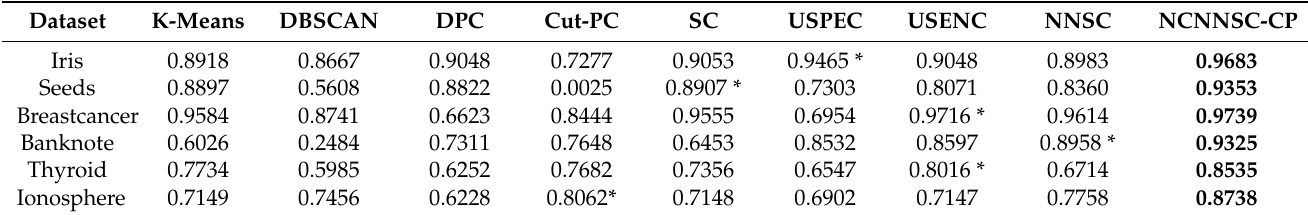
Table 5. The F-measure of the nine algorithms on six UCI datasets.